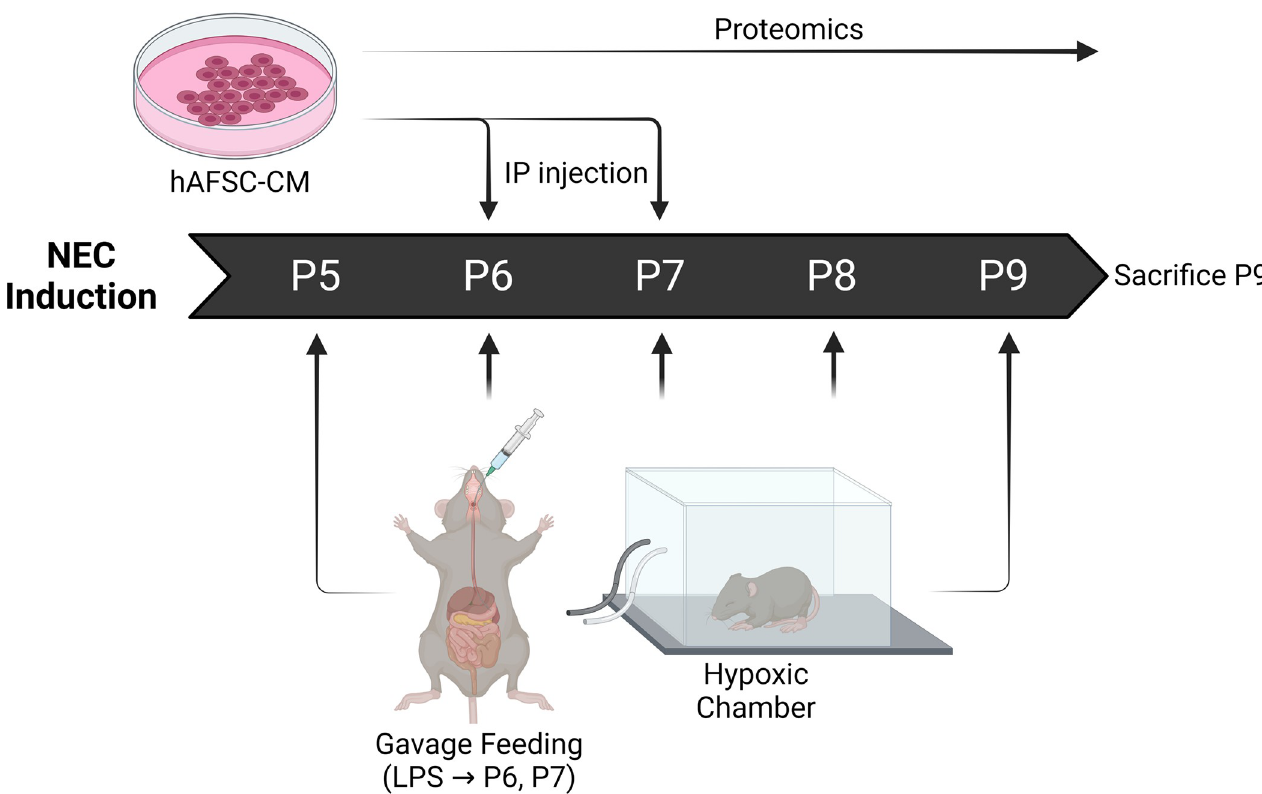
Fig 1. Schematic illustration of experimental NEC model and CM administration. From postnatal days (p) 5 to p9, mouse pups exposed to NEC induction, which including four times daily hyperosmolar formula feeding and hypoxia, and LPS administration on p6 and p7. AFSC-CM were collected, assessed by proteomics, and administered by intraperitoneal injection to the mice pups undergoing NEC induction on p6 and p7.